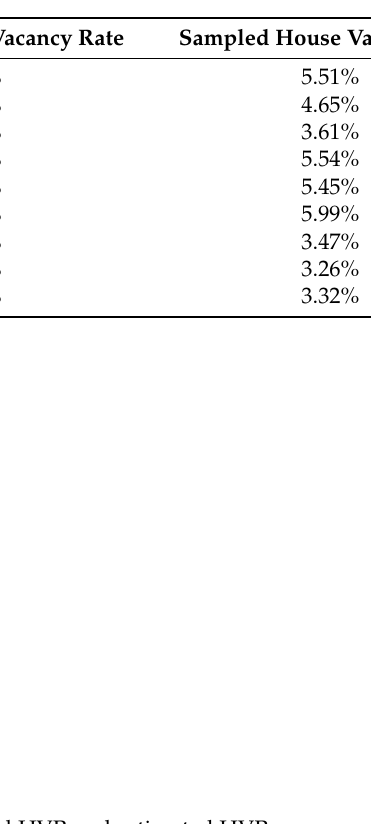
Table 3. The sampled HVR and the estimated HVR in Guangzhou.